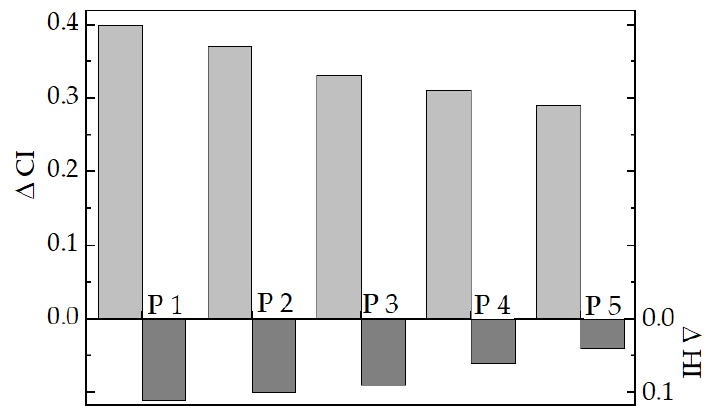
Figure 3. The oxidation indices after the thermal oxidation of studied LDPE / UHMWPE samples. P1 = LDPE / UHMWPE, P2 = LDPE / HAp, P3 = LDPE / HAp / RM, P4 = LDPE / UHMWPE / HAp, P5 = LDPE / UHMWPE / HAp / RM. CI, carbonyl; HI, hydroxyl.